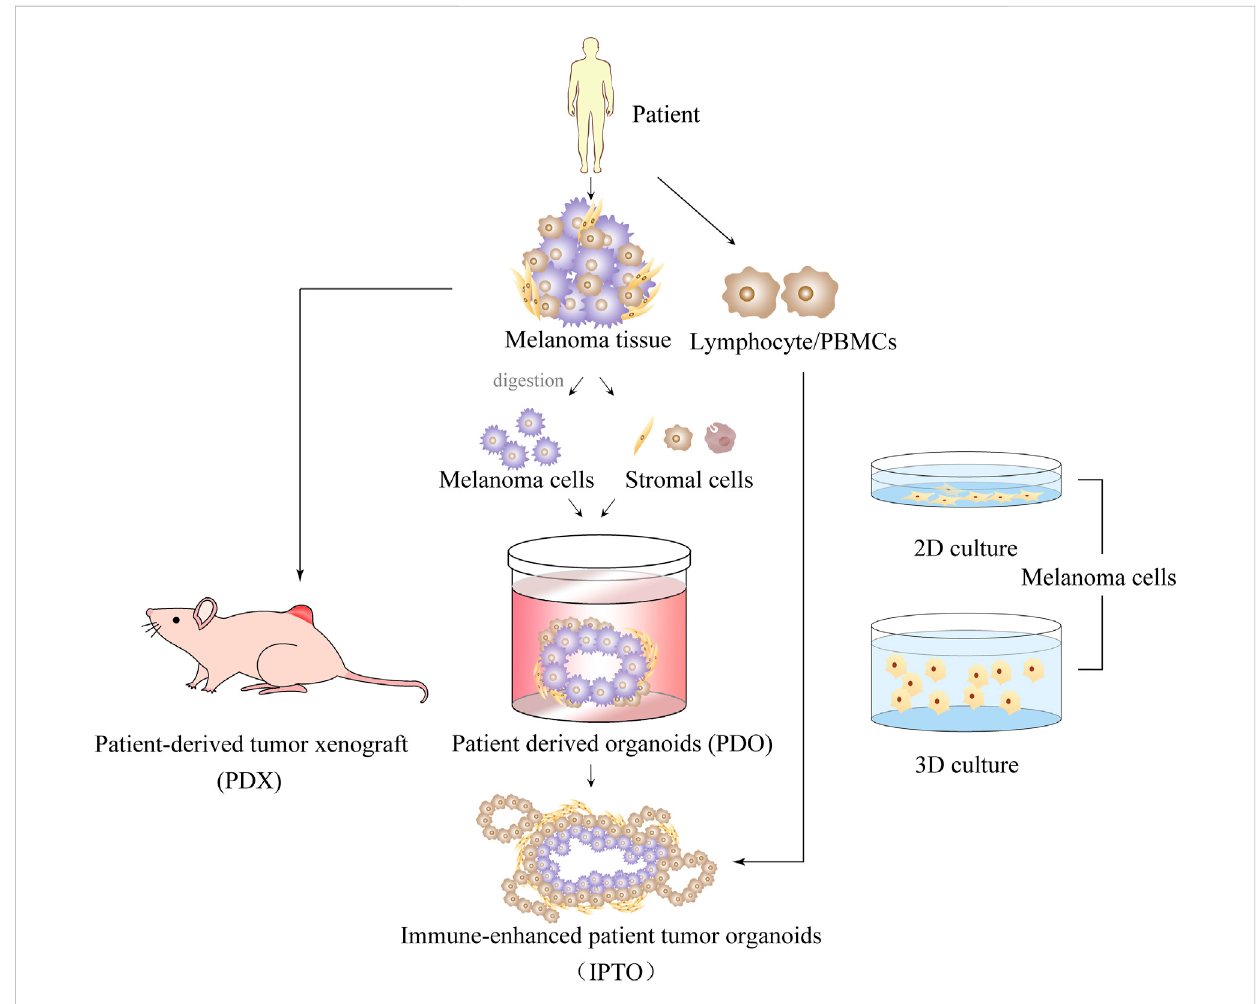
FIGURE 2 Introduction of 2D and 3D multiple melanoma culture